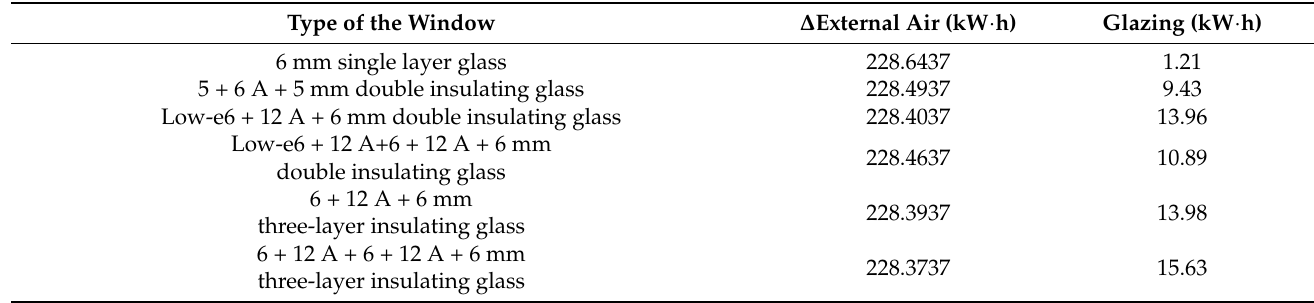
Table 10. Heat transfer coefficients of external